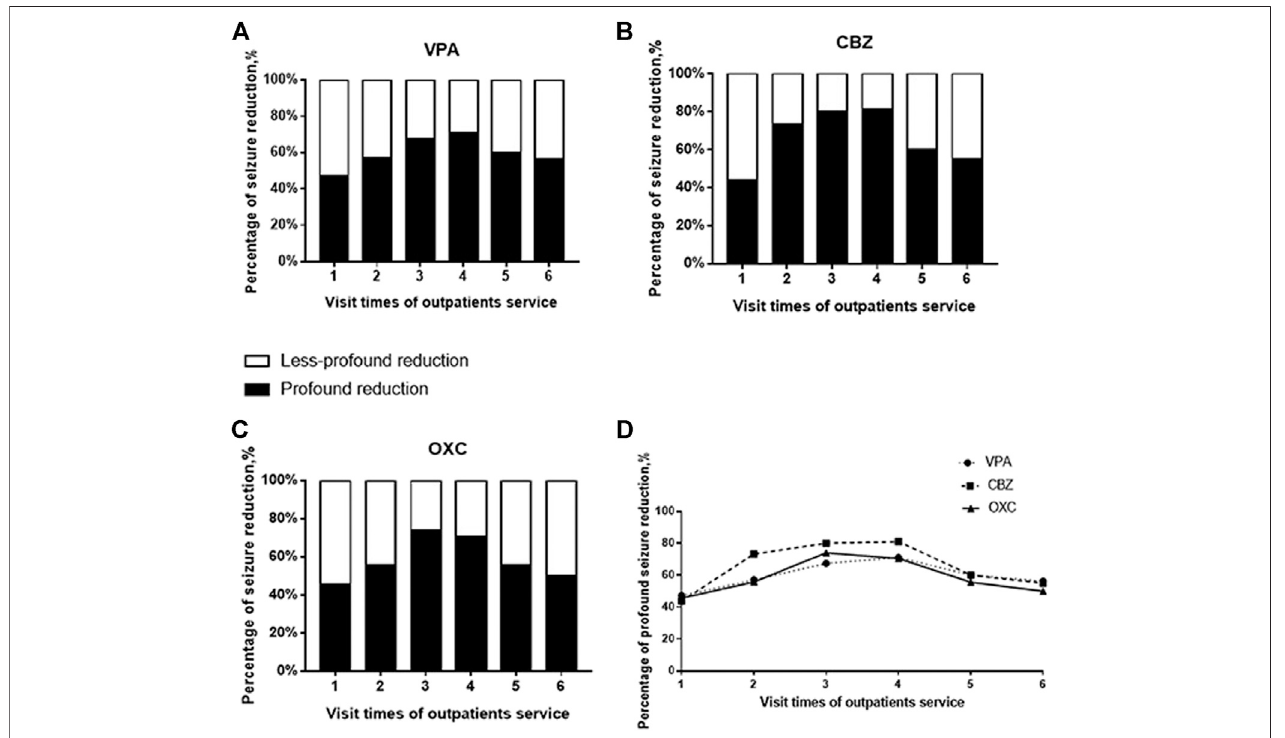
FIGURE 6 | Probability of AEDs having profound ef fi cacy based on the number of outpatient visits.